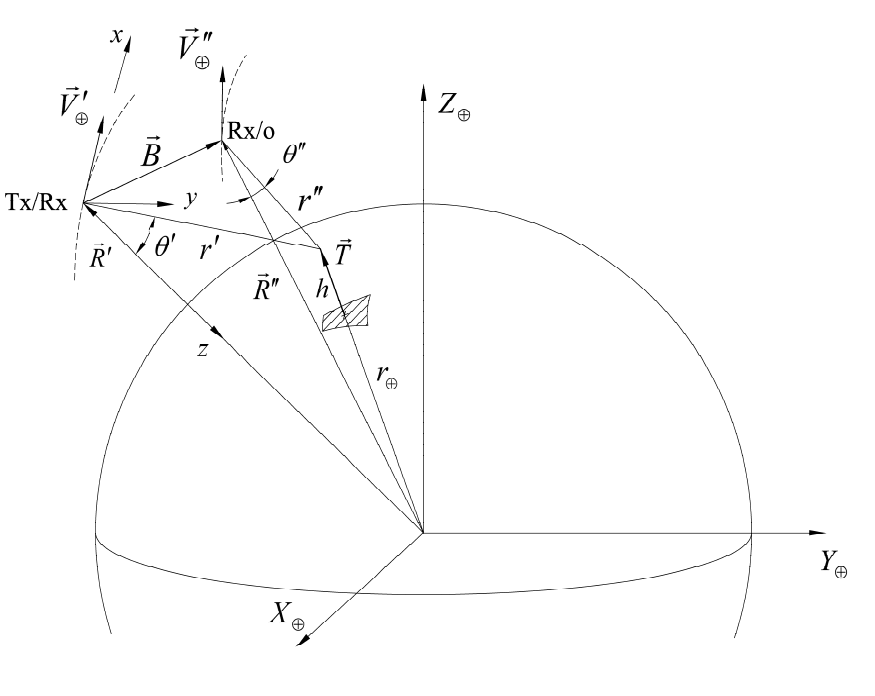
Figure 5. Three-dimensional viewing geometry of the monostatic-bistatic stereo-radargrammetric survey (not to scale for